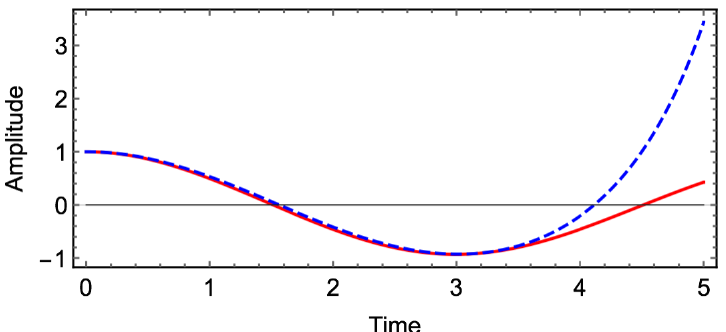
Figure 3. The red curve is the numerical solution and the dashed blue curve is the solution by the DTM in Equation